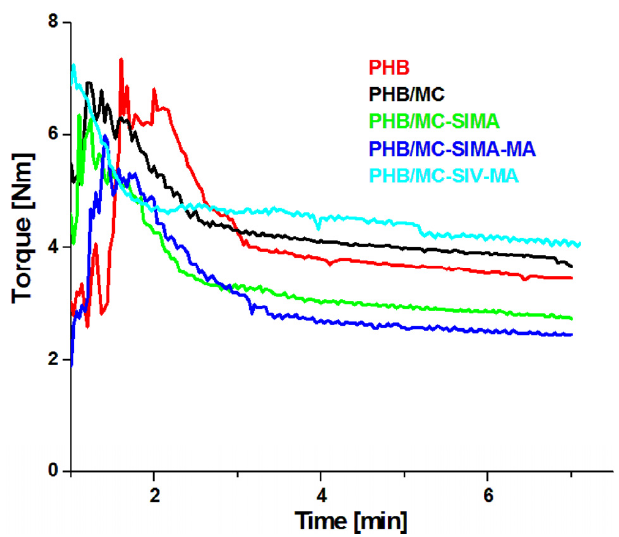
Figure 10. Torque vs. time diagrams recorded during the melt processing of PHB and composites .